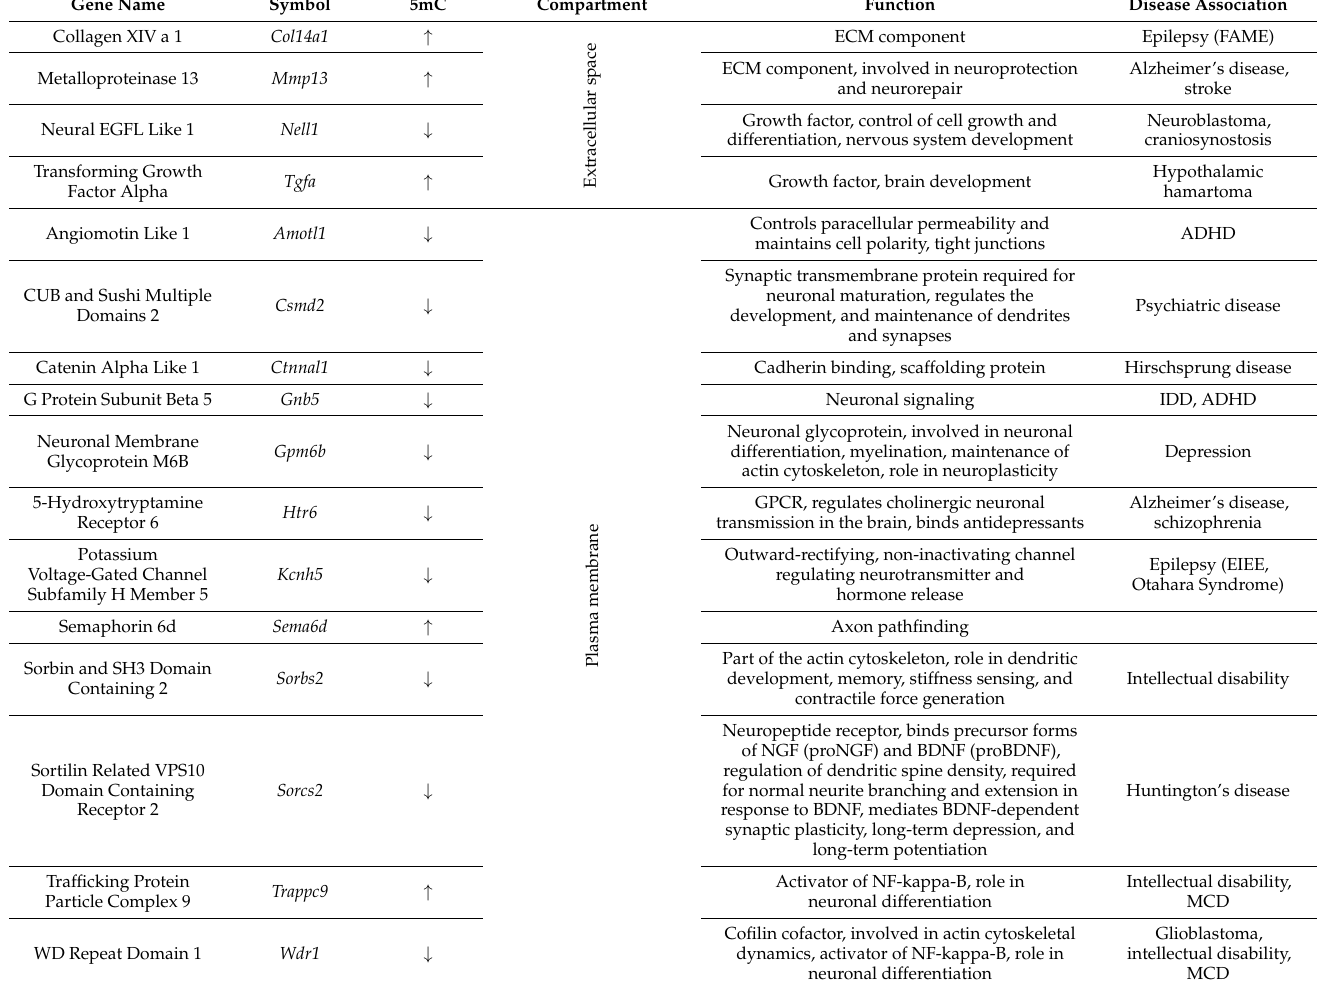
Table 1. DMGs with a role in brain development, function, and disease. 5mC—5-methyl-Cytosin/ DNA methylation, ADHD—attention deficit hyperactivity disorder, BDNF—brain derived neurotrophic factor, DMG—differentially methylated gene, ECM—extracellular matrix, EIEE—early infantile epileptic encephalopathy, ERK/MAPK—extracellular signal- regulated kinases/ mitogen—activated protein kinase, FAME—familial adult myoclonic epilepsy, GPCR—G—protein coupled receptor, IDD—intellectual developmental disorder, MCD—malformation of cortical development, mTOR— mammalian target of